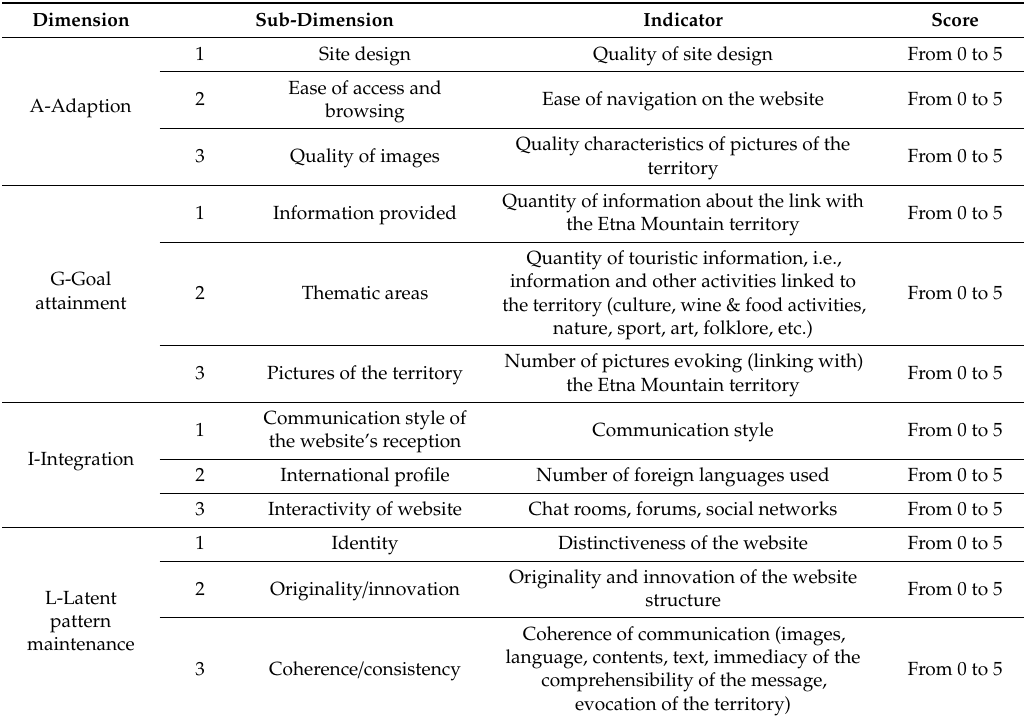
Table 3. Dimensions, sub-dimensions, indicators and score ranges used for the